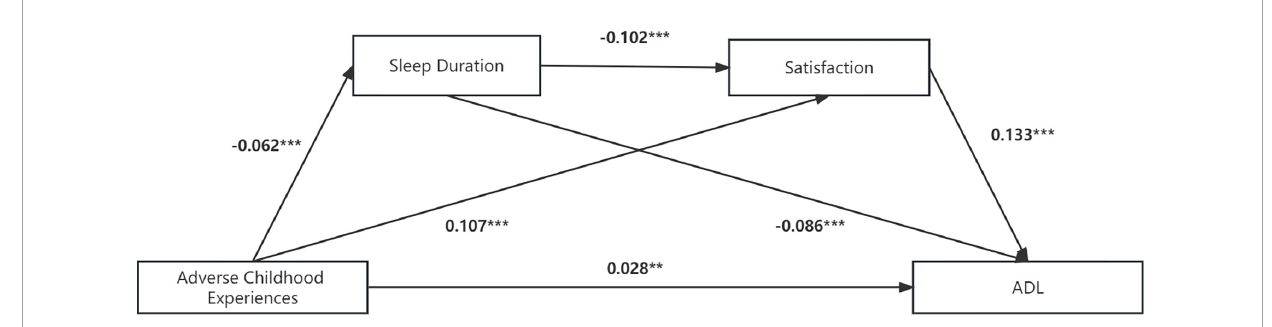
FIGURE3 Multiple mediation model between adverse childhood experiences and ADL with sleep duration and satisfaction as mediators. Path values are the path coefficients. ADL, Activities of daily living. *** P < 0.001 and ** P < 0.01.